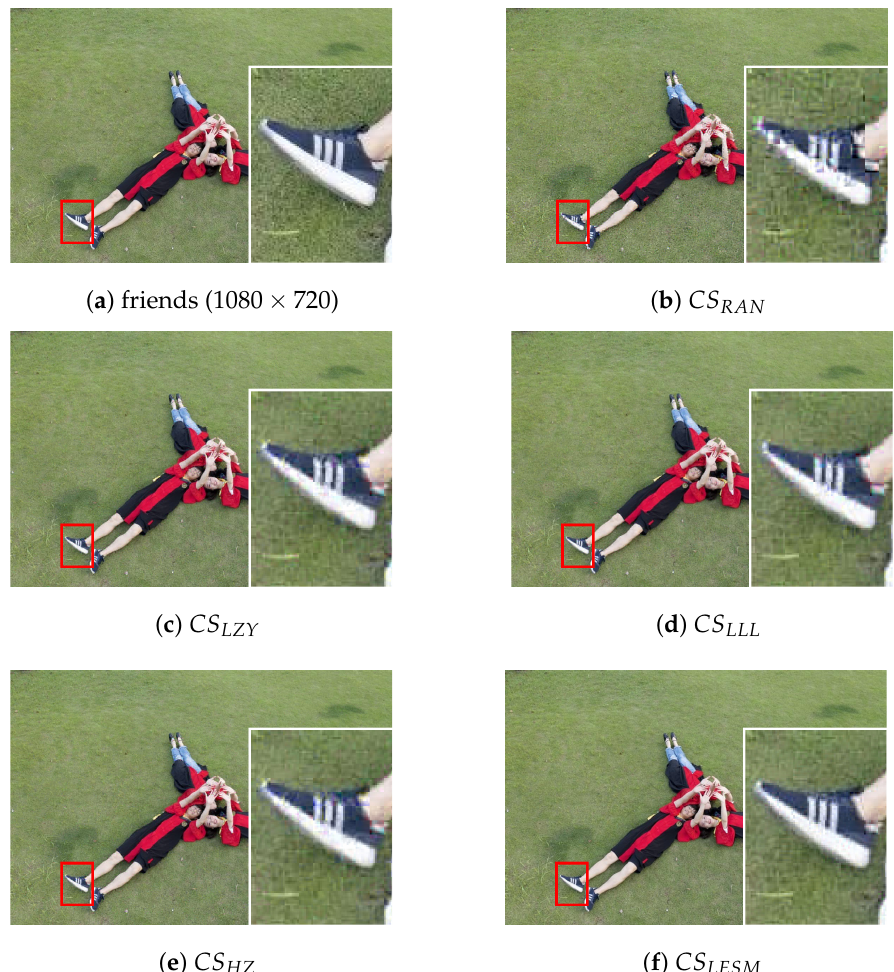
Figure 5. Recovery results for the UAV image "friends" taken by ourselves with no adding noise. ( a ) is the original image, ( b ) is the CS RAN algorithm, ( c ) is the CS LZY algorithm, ( d ) is the CS LLL algorithm, ( e ) is the CS HZ algorithm, and ( f ) is the CS LESM algorithm.